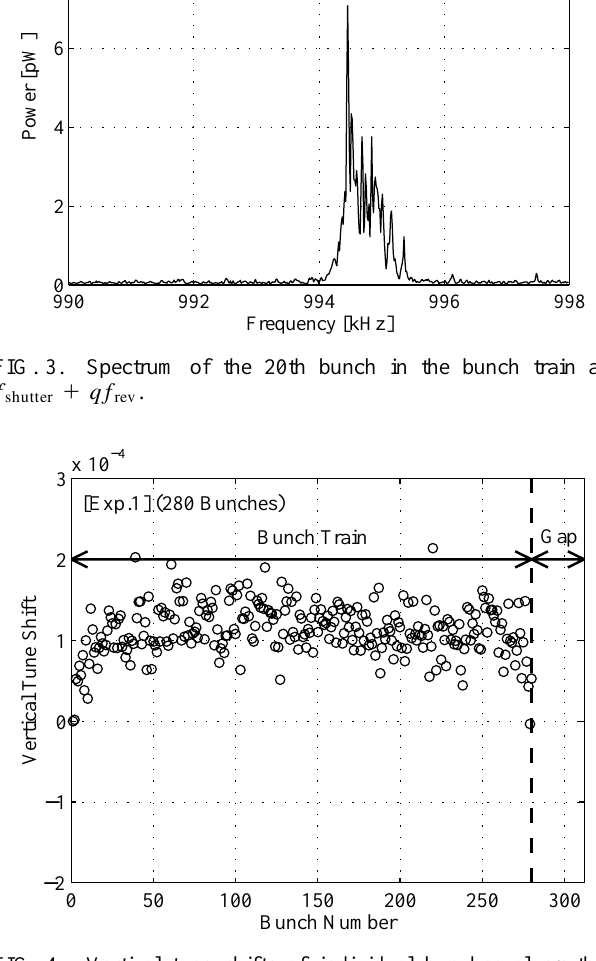
FIG. 4. Vertical tune shifts of individual bunches along the bunch train with 280 bunches.